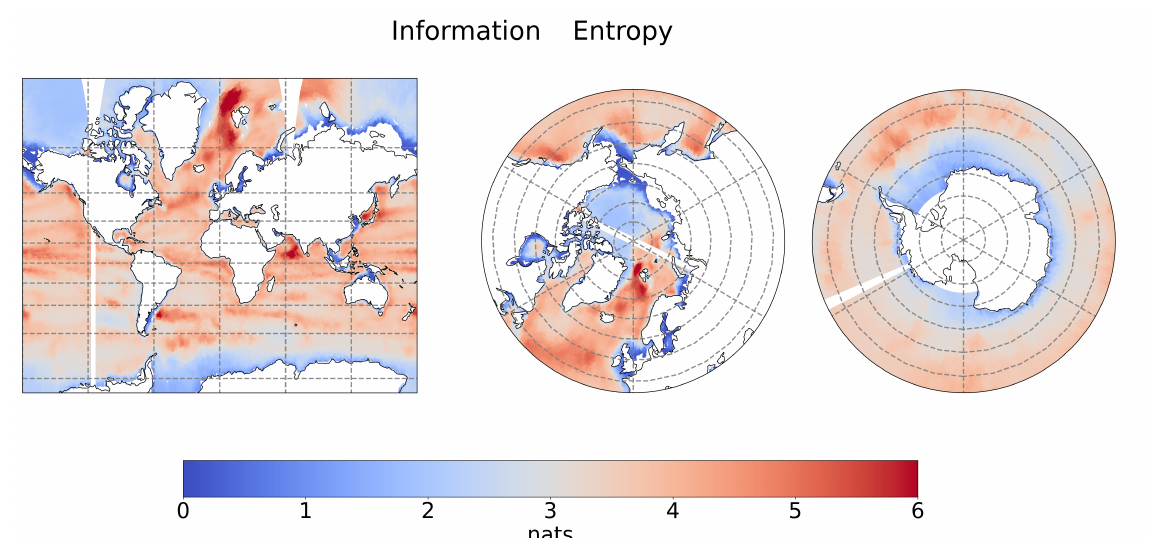
Figure 3. Information entropy field of the temperature at 135 m